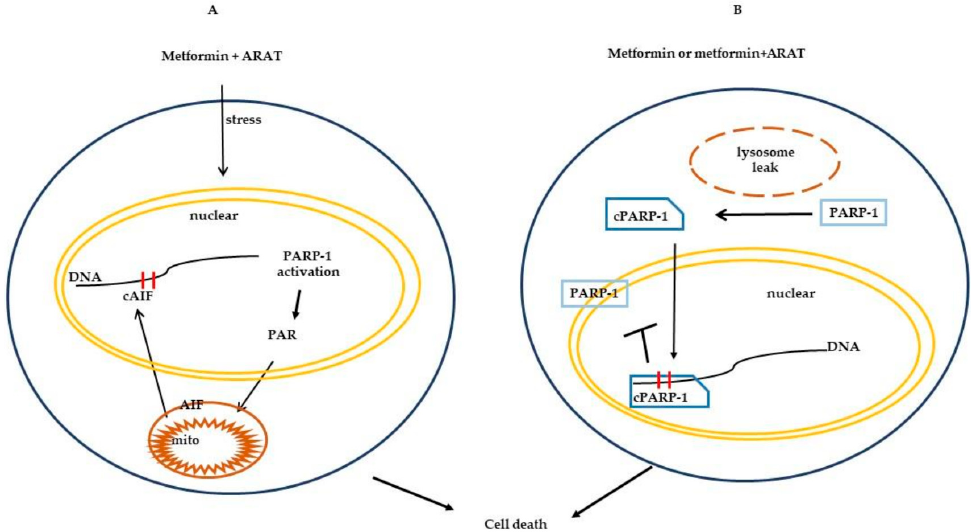
Figure 5. Schematic: recruitment of PARP-1-dependent cell death in PC cells by metformin and ARAT (Abi, Enz) combinations. ( A ) Cellular stress induced by metformin/ARATs leads to PARP-1 activation, increase PAR production and cAIF nuclear accumulation. ( B ) Metformin or metformin/ARATs induce cathepsin leak from lysosomes resulting in cleavage of PARP-1, cPARP-1 then binds DNA to prevent uncleaved PARP-1 from accessing DNA for repair.